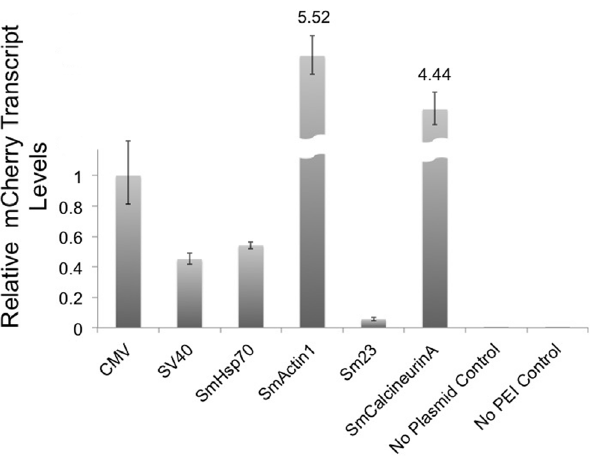
Figure 2. qRT-PCR quantitation of the mCherry transcript in schistosomes transfected with vectors expressing this reporter gene regulated by different promoters. Two viral promoters and four endogenous schistosome promoters were assayed for their ability to express an mCherry reporter. Schistosome samples treated with PEI only or DNA only were used as negative controls. All samples were normalized against the CMV samples.